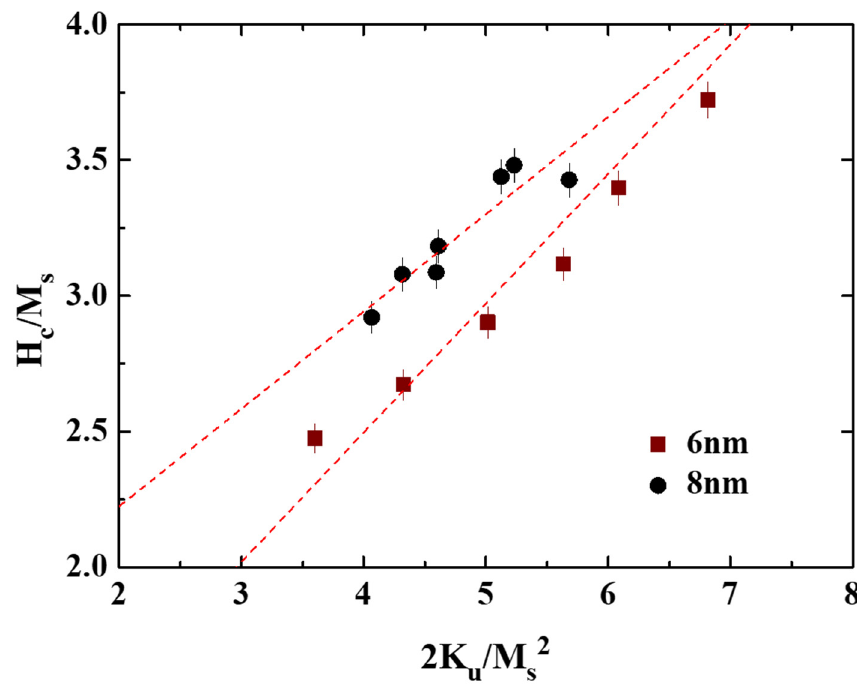
Figure 10. The microstructural parameter determination of the FePt(B, Ag, C)(8 nm)/MgTiON/CrRu